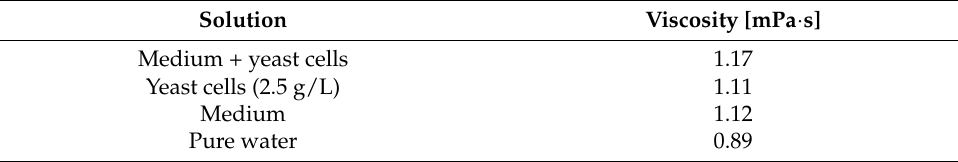
Table 2. Viscosity of each solution used in filtration experiments at 25 °C.